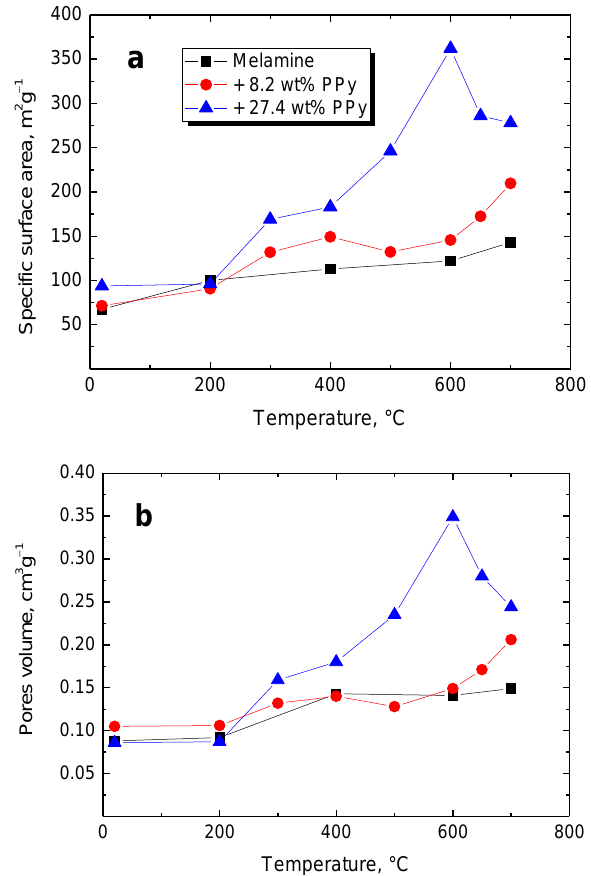
Figure 9. ( a ) Specific surface area, and ( b ) pores volume of the sponges after exposure to various temperatures.